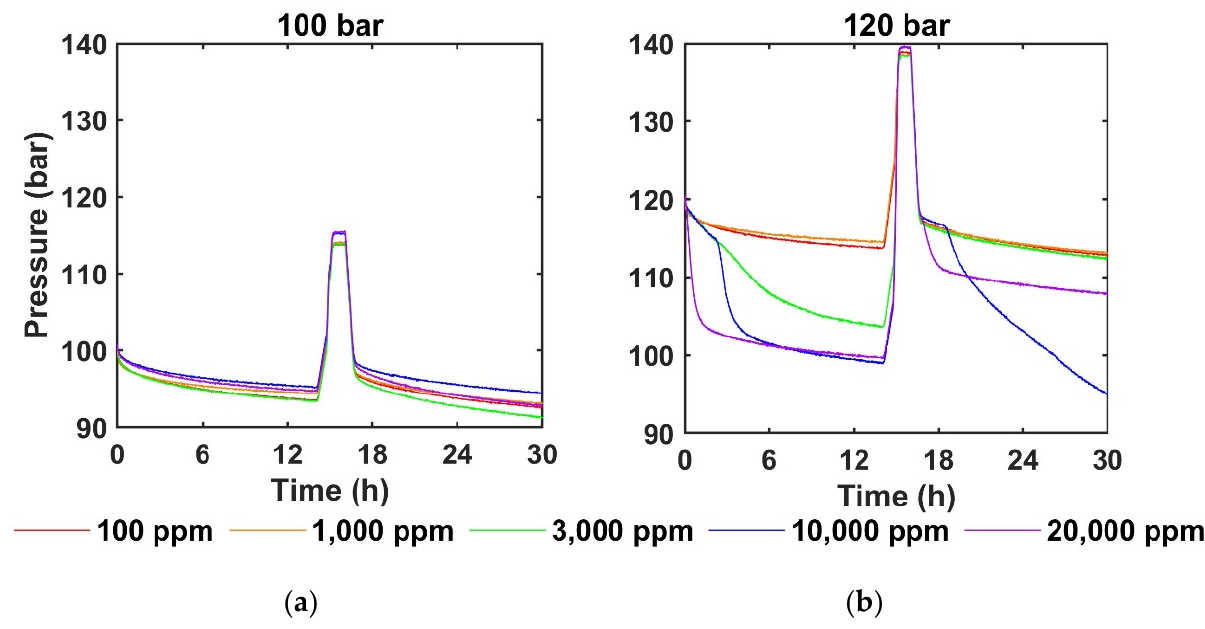
Figure 7. Pressure variation (for fresh and memory run) during the isothermal experiment temperature (T = 1 °C) scheme (in the presence of L-histidine) at five different concentrations (100 ppm to 20,000 ppm) for two different pressures (100 bar and 120 bar). ( a ) Pressure profiles during isothermal under 100 initial bar pressure (no rapid pressure drops observed) and ( b ) pressure profiles during an isothermal experiment under 120 initial bar pressure. (Rapid pressure drops observed for 3000 ppm concentration and above).